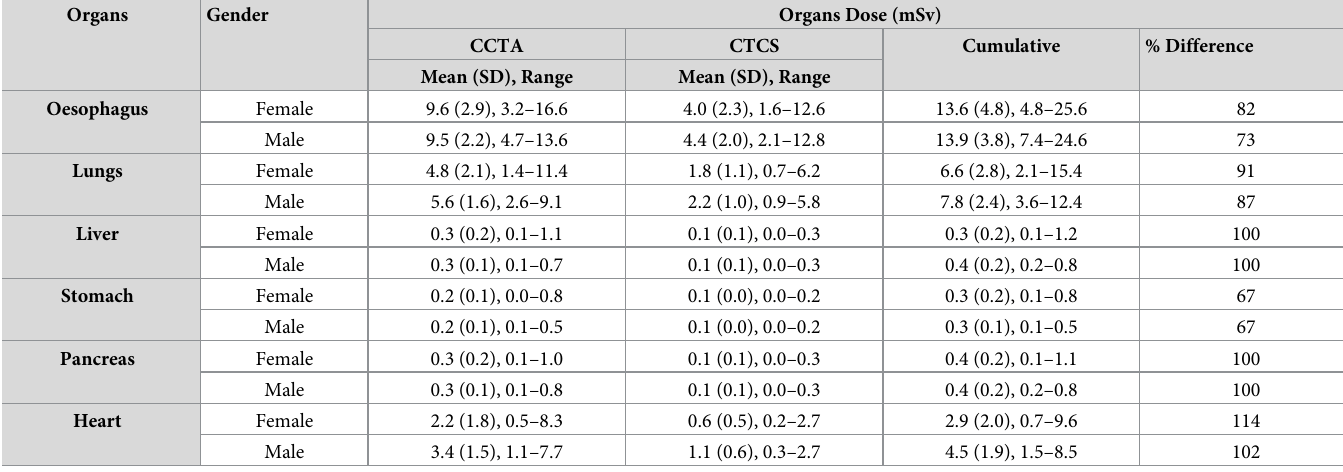
Table 4. Organs Dose comparison between CTCA and CTCS based on gender, generated using CT EXPO, comparing the mean of CCTA to CTCS. Organs